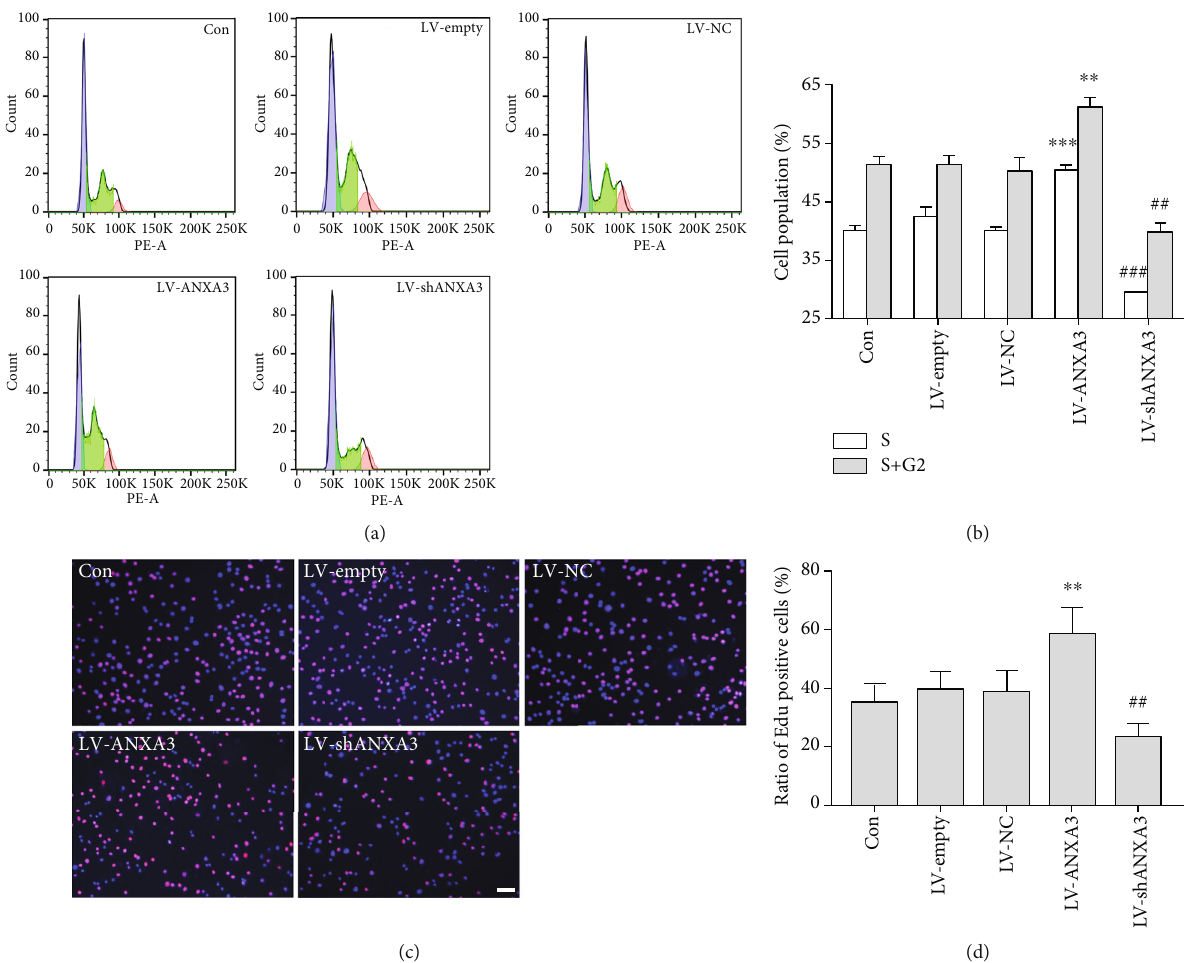
Figure 8: The proliferation of microglial N9 cells. (a, b) Flow cytometry analysis showing the proliferation of the Con, LV-empty, LV-NC, LV-ANXA3, and LV-shANXA3-treated N9 microglial cells. MultiCycle AV software was used to perform the fi t analysis of the DNA cell cycle and to calculate the percentages of cells in each phase. The blue peak, the green arc-shaped hatched portion in the middle, and the red peak represent the G1, S, and G2 phases of the cell cycle, respectively. The data are expressed as the means ± SD and were analyzed by one-way ANOVA with Tukey ’ s post hoc test. ∗∗ p < 0 : 01 and ∗∗∗ p < 0 : 001 compared with the LV-empty group. ## p < 0 : 01 and ### p < 0 : 001 compared with the LV-NC group. The data were pooled from fi ve independent experiments. (c, d) The EdU incorporation assay showing the proliferation of the Con, LV-empty, LV-NC, LV-ANXA3, and LV-shANXA3-treated N9 microglial cells. The cell nuclei were stained with DAPI. EdU-positive cells are indicated in pink. The data are expressed as the means ± SD and were analyzed by one-way ANOVA with Tukey ’ s post hoc test. ∗∗ p < 0 : 01 compared with the LV-empty group. ## p < 0 : 01 compared with the LV-NC group. The data were pooled from fi ve independent experiments. Scale bar = 20 μ m . DAPI: 4 ′ ,6-diamidino-2-phenylindole; EdU: 5-ethynyl-2 ′